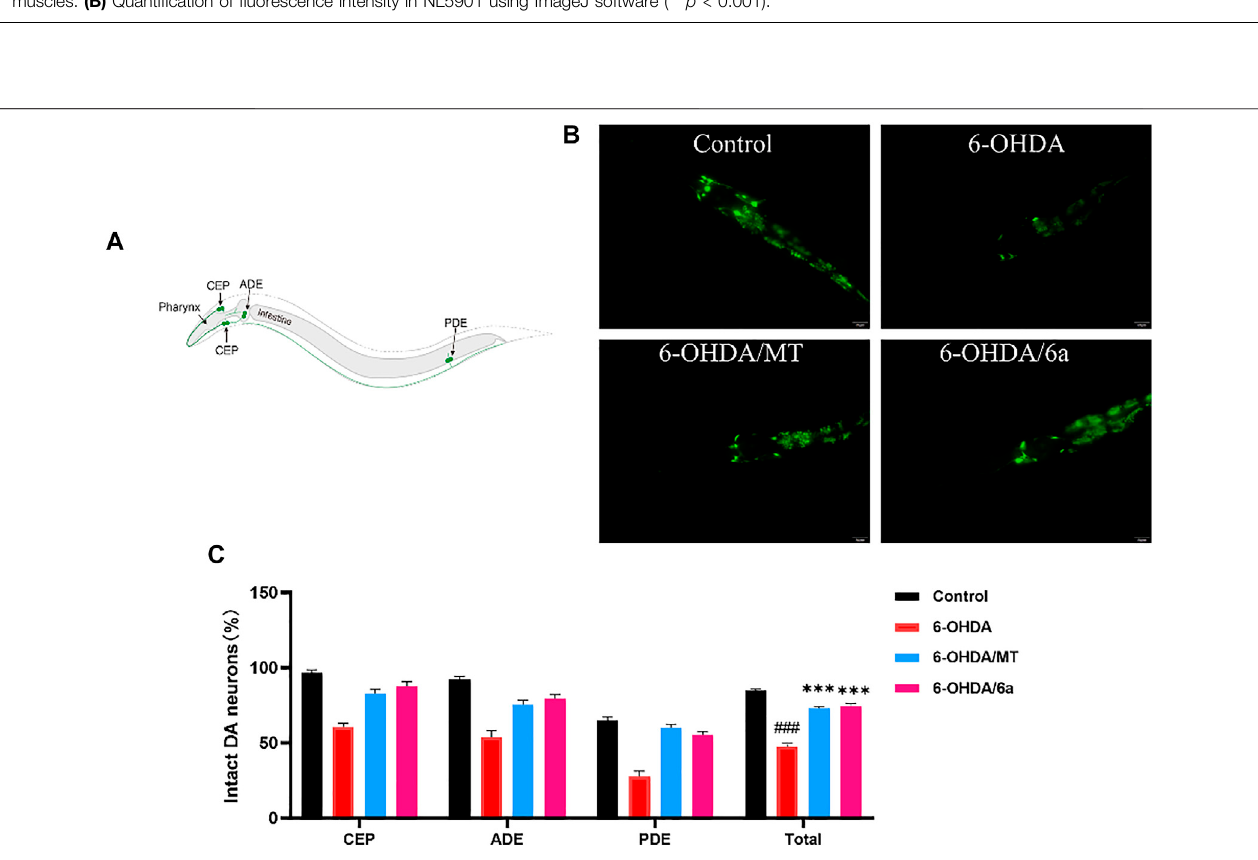
FIGURE 6 | Effect of MT and 6a on restoration of 6-OHDA-induced DA neurodegeneration in the BZ555 strain. (A) Neuronal circuits in C. elegans. (B) GFP expression patterns of CEP and ADE in BZ555. (C) Quanti fi cation of the fl uorescence intensity of all eight DA neurons of BZ555. (### p < 0.001, compared with the control; *** p < 0.001, compared with the 6-OHDA-treated group).